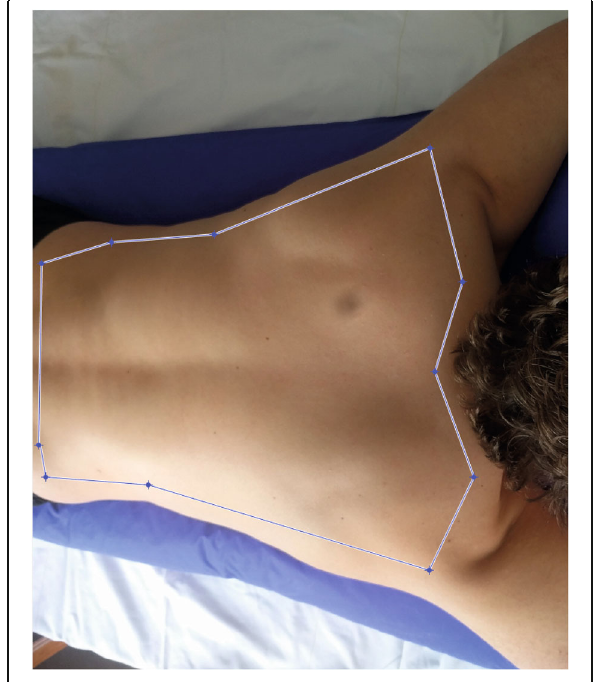
Fig. 3 Screenshot of ROI selection process. The colour image is captured by the Kinect and the blue lines represent the border of the selected ROI